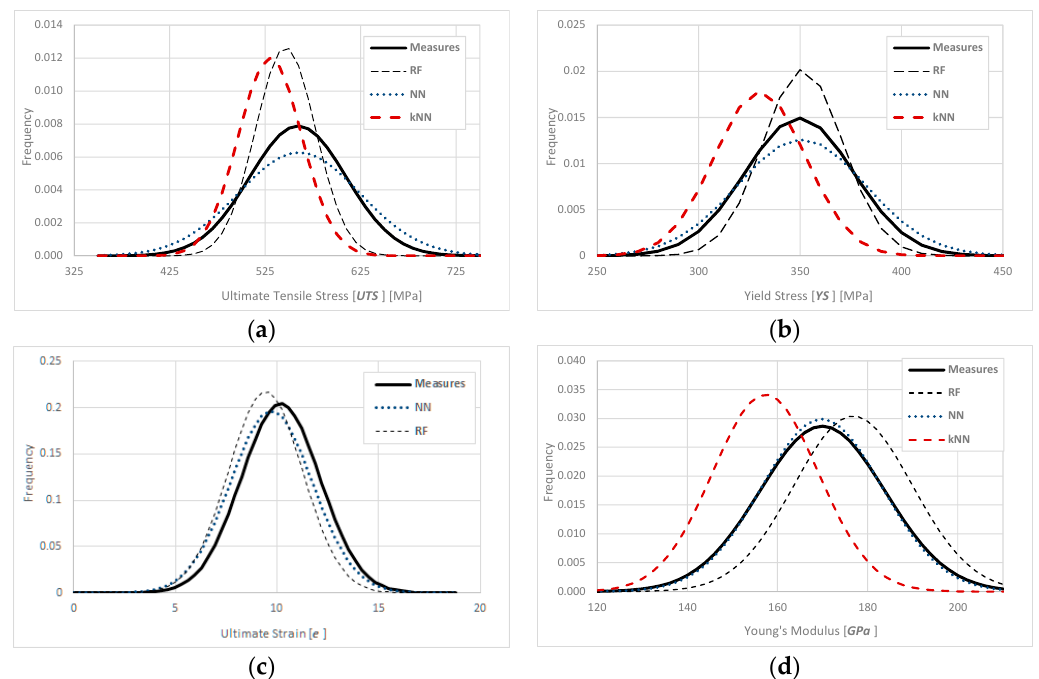
Figure 3. Comparison between measured and predicted values in terms of density functions (case of SGI) for: ( a ) Ultimate Tensile Stress; ( b ) Yield Stress; ( c ) Ultimate Strain; ( d ) Young’s